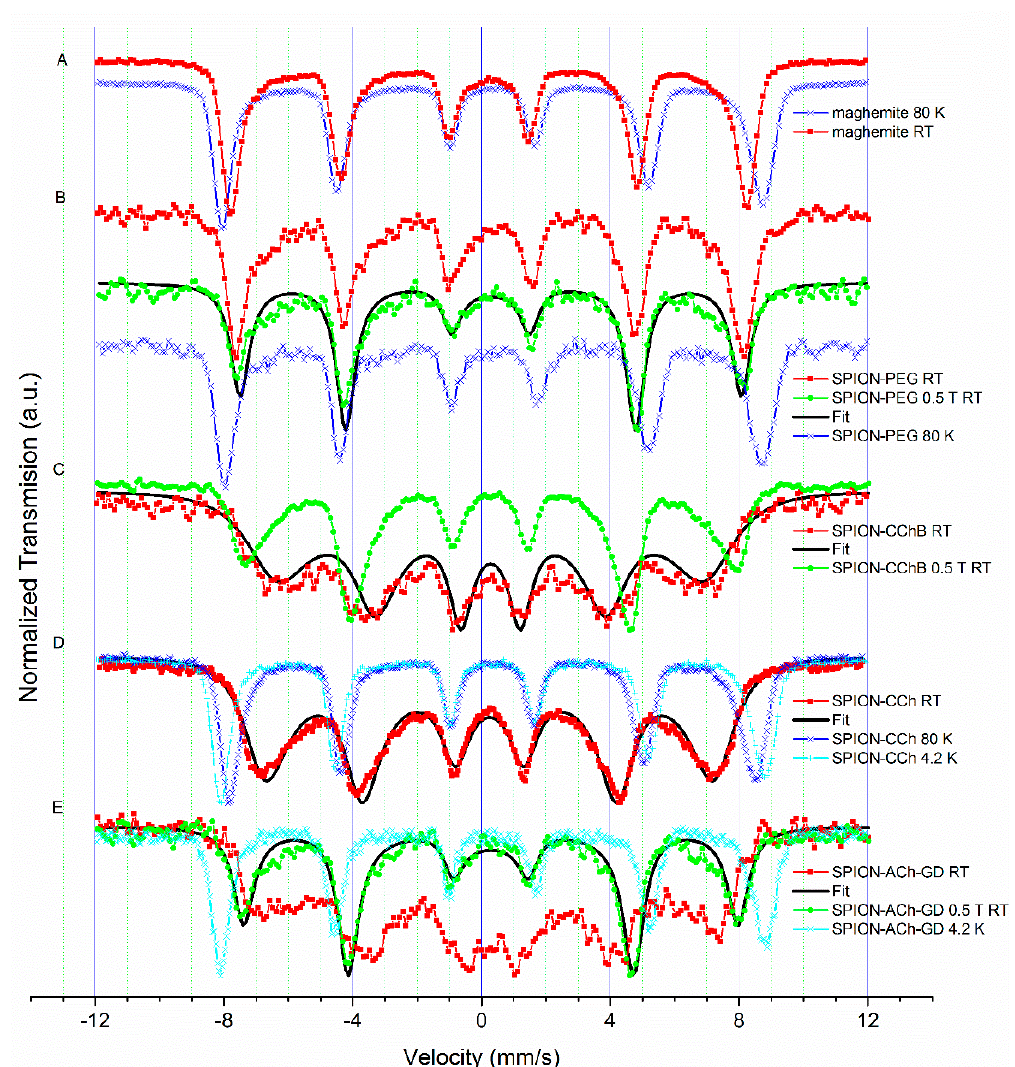
Figure 3. Mössbauer spectra normalized to their most intense lines for all the investigated nanoparticle materials at various temperatures at zero field and in the applied magnetic field ( B = 0.5 T). Solid black lines are exemplary fits to the measured relaxational spectra. The spectra of microcrystalline maghemite are also shown.